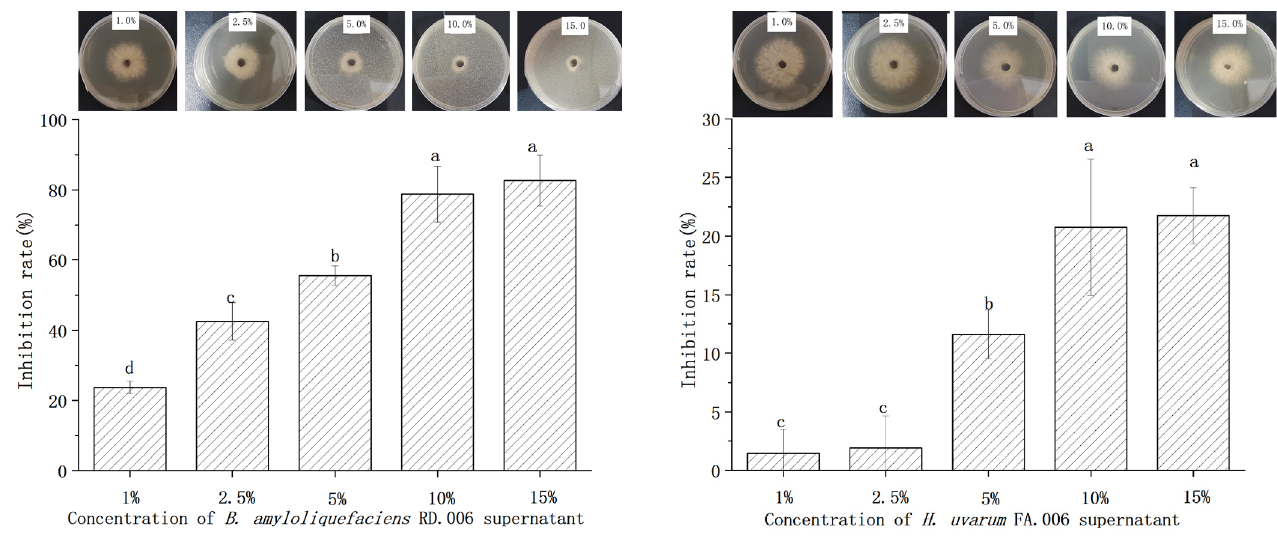
Figure 4. Antifungal activities of cell-free culture supernatants from B. amyloliquefaciens RD.006 ( A ) and H. uvarum FA.006 ( B ) at different concentrations. Error bars represent standard deviations from the mean. a–d: different letters above bars indicate significant differences at p < 0.05.